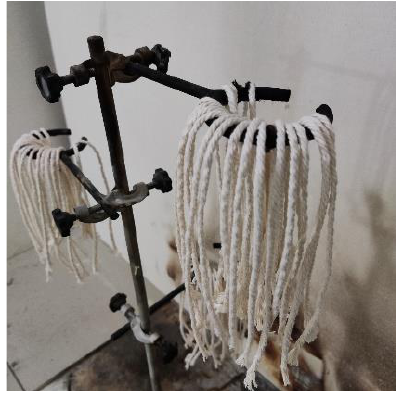
Figure 16. Cotton rope to be ignited.